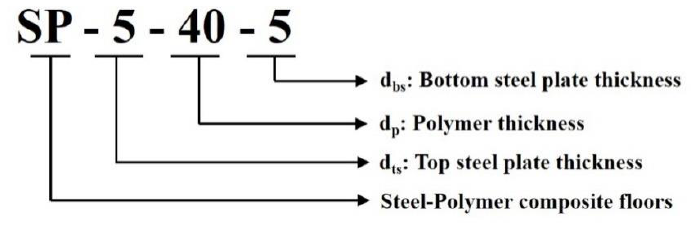
Figure 10. Description of analysis model label.